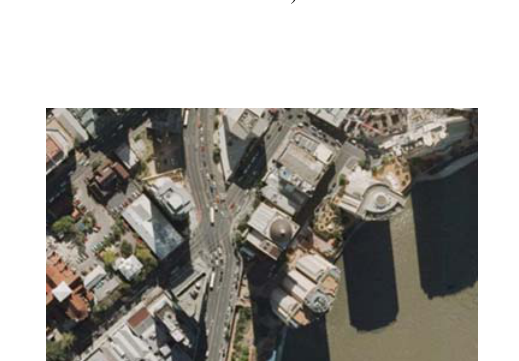
Figure 7. Computed GroundOrthoimage (left: cutline, right: